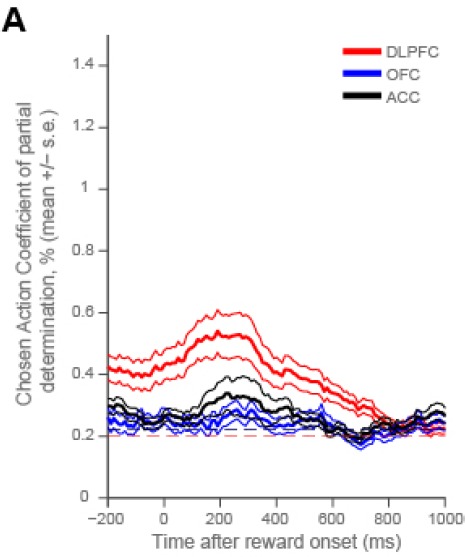
Population averages when chosen action was regressed onto firing rate during reward delivery.DLPFC showed stronger chosen action correlates following reward onset than ACC and OFC (permutation tests; DLPFC v OFC, p = 0.0006, DLPFC v ACC, p = 0.0002; see Methods). Dashed lines mark the null hypothesis level for CPD in each cortical area (see Methods).